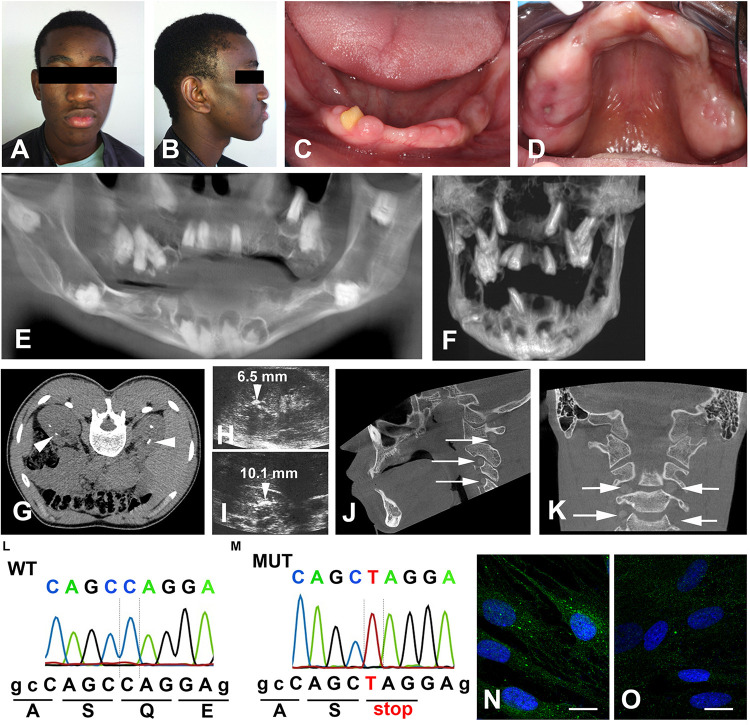
Clinical features of the proband. Front (A) and side (B) photos showing facial asymmetry, ocular hypertelorism and dense, bushy eyebrows. (C,D) Generalized gingival enlargement and a yellow–brown discoloration of the unique erupted tooth. (E) CBCT reconstruction; agenesis of 11, 14, 18, 28, 31, 36, 41, 42, 45, and 46; multiple unerupted teeth; large radiolucent pericoronal areas associated with impacted molars. (F) Mandibular and maxillary CBCT reconstruction. Note the displacement of the premolars into the maxillary sinus and the molars in the mandibular canal. (G) Renal axial CT-scan and (H,I) ultrasound showing bilateral medullary nephrocalcinosis (arrowheads). (J) Sagittal and (K) para-sagittal CBCT scans reveal round bilateral calcifications within the foramens of the cranial vertebrae (arrows). (L,M) Sequencing chromatograms of FAM20A exon 1 of a control (L) and proband (M). The homozygous nonsense mutation, c.358C > T causes a premature termination at p.Gln120*. (N) Vesicular distribution of FAM20A in control gingival fibroblasts. (O) Loss of FAM20A staining in the proband’s gingival fibroblasts. Scale bars: (O), P = 20 μm.